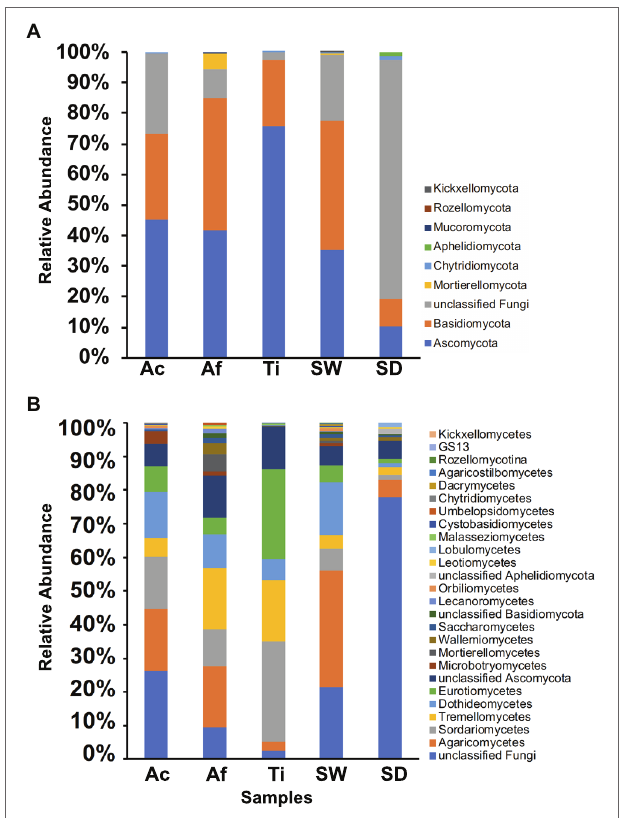
FIGURE 5 | Fungal community composition for Ac ( Aplysina caissara ), Af ( Aplysina fulva ), Ti ( Tedania ignis ), SW (seawater), and SD (sediment) are shown for nine phyla (A) and for 26 classes (B)